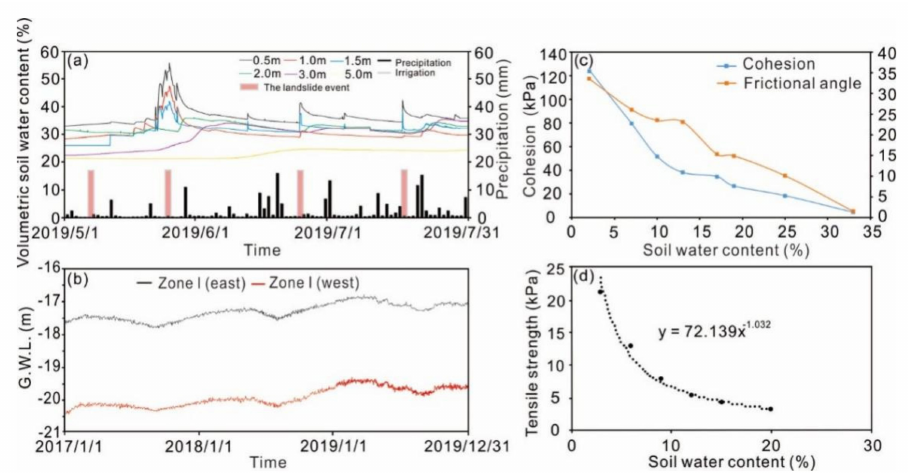
Figure 6. Irrigation-effect on groundwater level, soil moisture and soil strength: ( a ) changes of soil moisture after irrigation and precipitation; ( b ) GWL, Groundwater level change curve with time; ( c ) shear strength of triaxial shear test; ( d ) tensile strength of uniaxial tensile